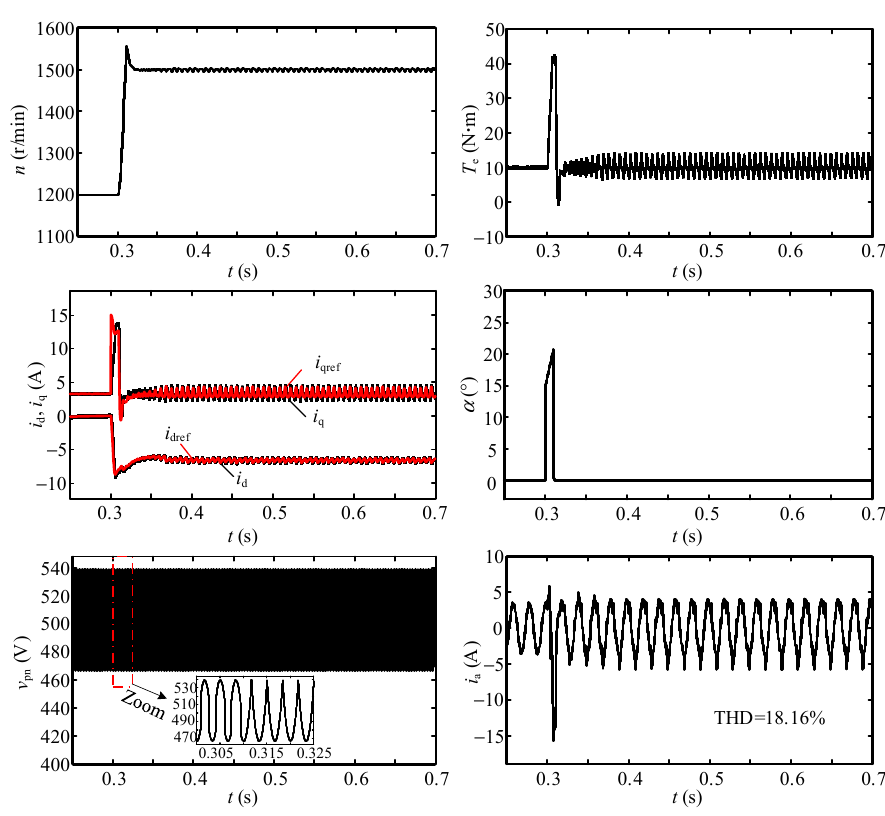
Figure 12. Simulation waveforms of operation Region B.